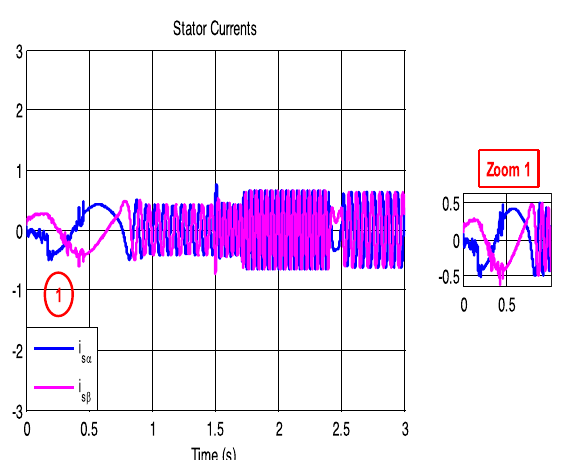
Fig. 26 PI-DTC-SPWM with three-level inverter stator current components